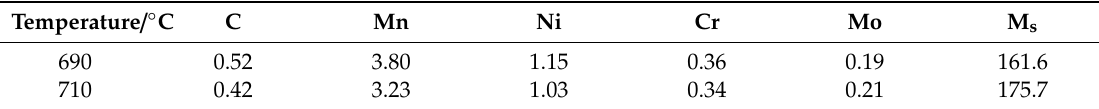
Table 2. Elemental mass fraction (%) for equilibrium austenite phase of SA738 Gr.B steel at di ff erent tempering temperatures and M s ( ◦ C)